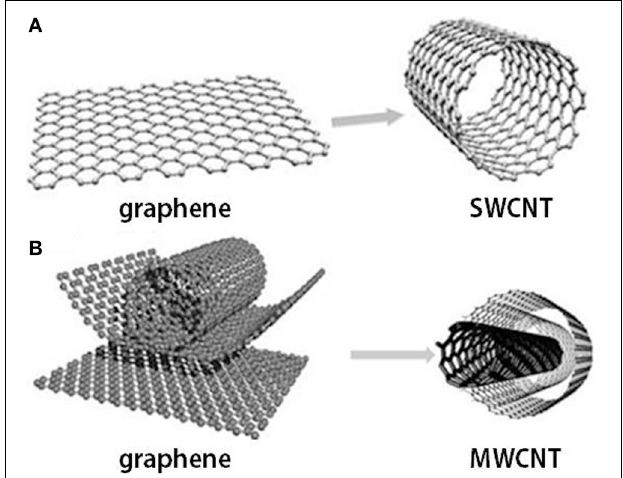
FIGURE 2 | Graphene and carbon nanotubes as (A) single wall carbon nanotube (SWCNT) and (B) multi-wall carbon nanotube (MWCNT)